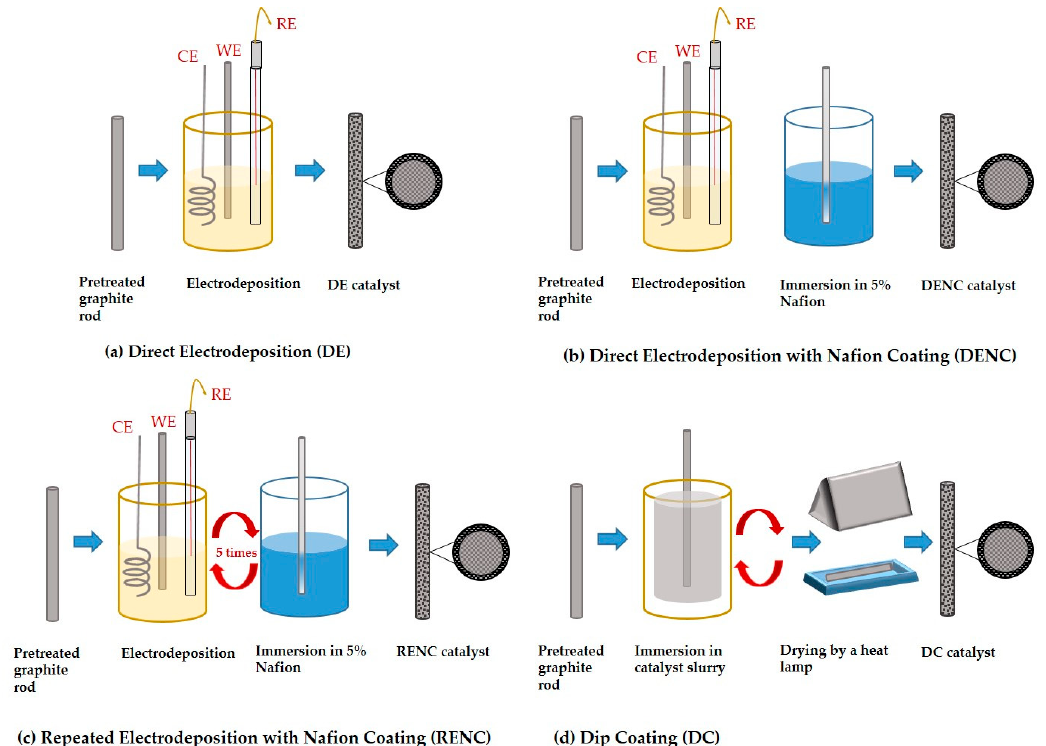
Figure 2. Schematic showing the procedure for fabricating the Pd catalyst on graphite rods through different routes: ( a ) Direct electrodeposition (DE), ( b ) Direct electrodeposition with Nafion coating (DENC), ( c ) Repeated electrodeposition with Nafion coating (RENC), and ( d ) Dip coating (DC) [46].